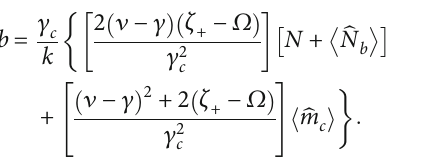
= 0 : 4 , κ = 0 : 8 , N = 50 , γ = 0 : 2, and for di ff erent values of ε c